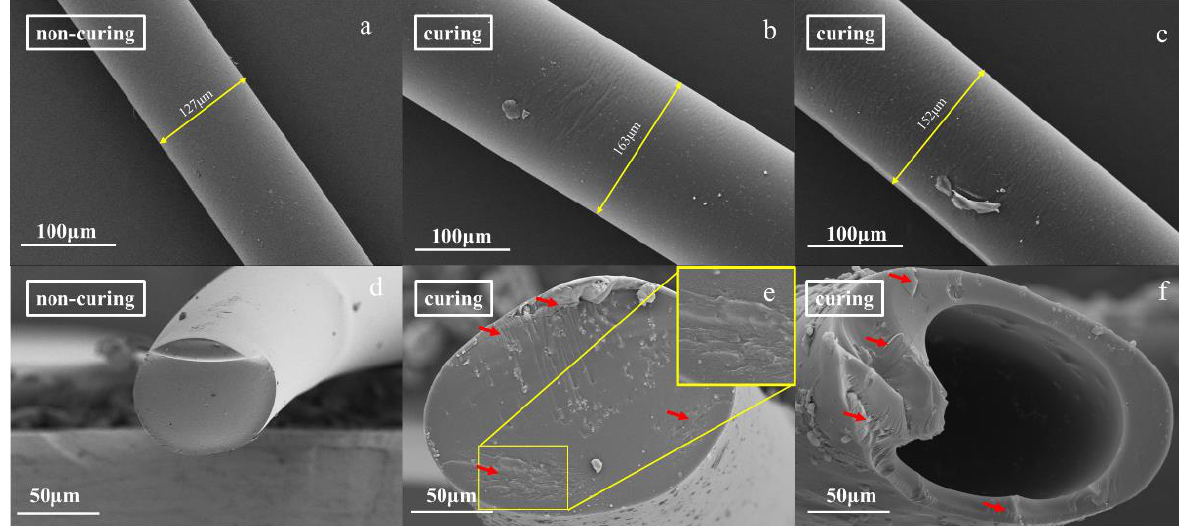
Figure 7. SEM micrographs of the surface and cross section of the 10% LPF and 20% LPF. ( a , d ) surface and section of 10% LPF; ( b , e ) surface and section of 10% LPF cured fiber; ( c , f ) surface and section of 20% LPF cured fiber.